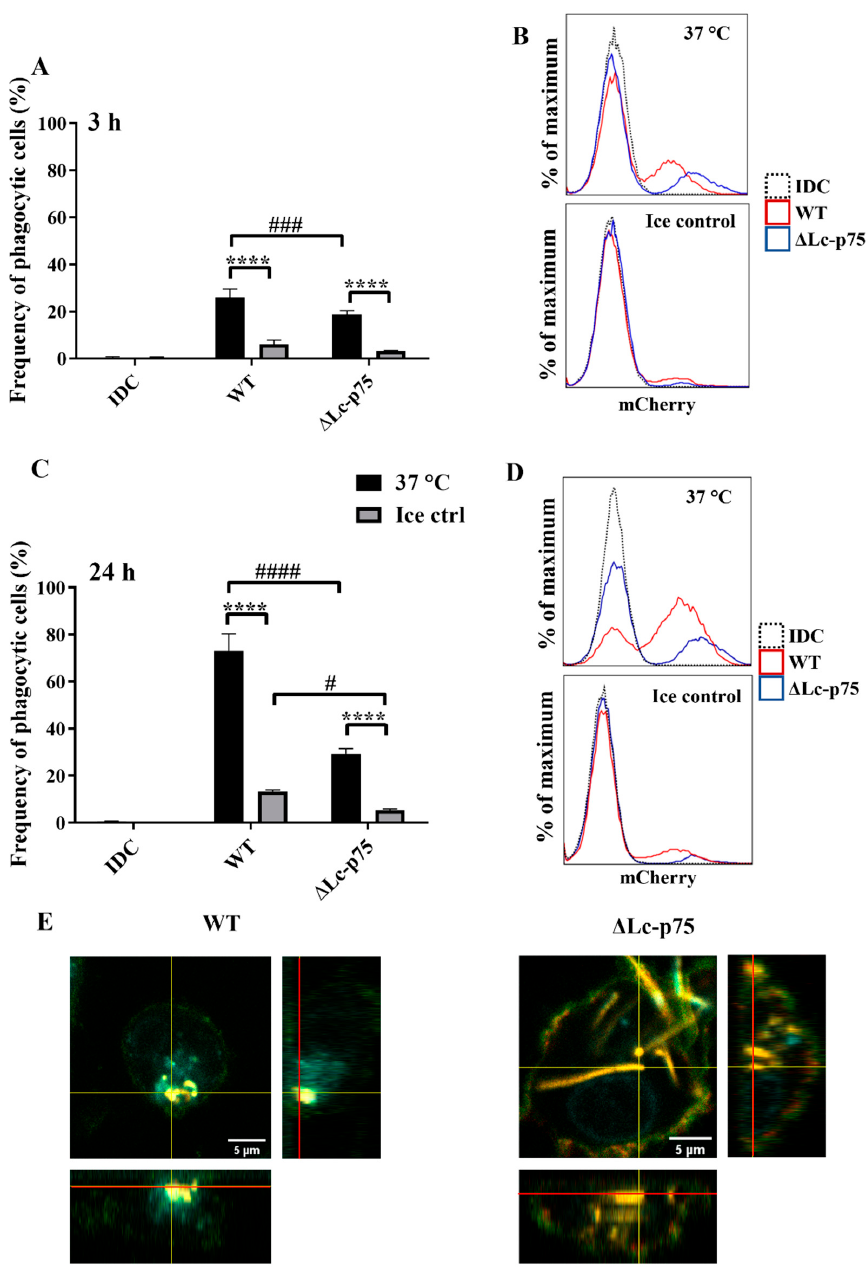
Figure 5. Inactivation of Lc-p75 in L. casei BL23 alters the phagocytic efficiency of moDCs. In vitro differentiated five-day moDCs were coincubated with mCherry-labeled WT L. casei BL23 and ∆ Lc-p75 mutant for 3 and 24 h at a ratio of 1:4 at 37 ◦ C and on ice as a control. Phagocytic activity of moDCs was measured by detecting mCherry fluorescent protein-positive moDCs with flow cytometry after 3 h ( A , B ) and after 24 h ( C , D ). IDC means nonactivated moDCs. Histogram overlays show the results of one representative experiment. On the flow cytometric figures, the mean values of 3 independent experiments are presented ± SD. For confocal microscopic pictures ( E ), moDCs are labeled with HLA-DQ (green), CD1a (red), and DAPI (cyan); mCherry is indicated with yellow. Orthogonal views are demonstrated for one Z-stack image. On the bottom is Z-projection in the X–Z direction, on the right is the Z-projection in the Y–Z direction. The red lines indicate the Z-depth of the optical slice and the orthogonal planes of the X–Z and Y–Z projections, respectively. Two-way ANOVA followed by Tukey’s multiple-comparison tests were used in the statistical analysis. Significance was defined as **** p < 0.0001 showing the differences between the samples incubated at 37 ◦ C and on ice. The differences between WT and ∆ Lc-p75 were statistically significant and defined as # p < 0.05, ### p < 0.001, and #### p <